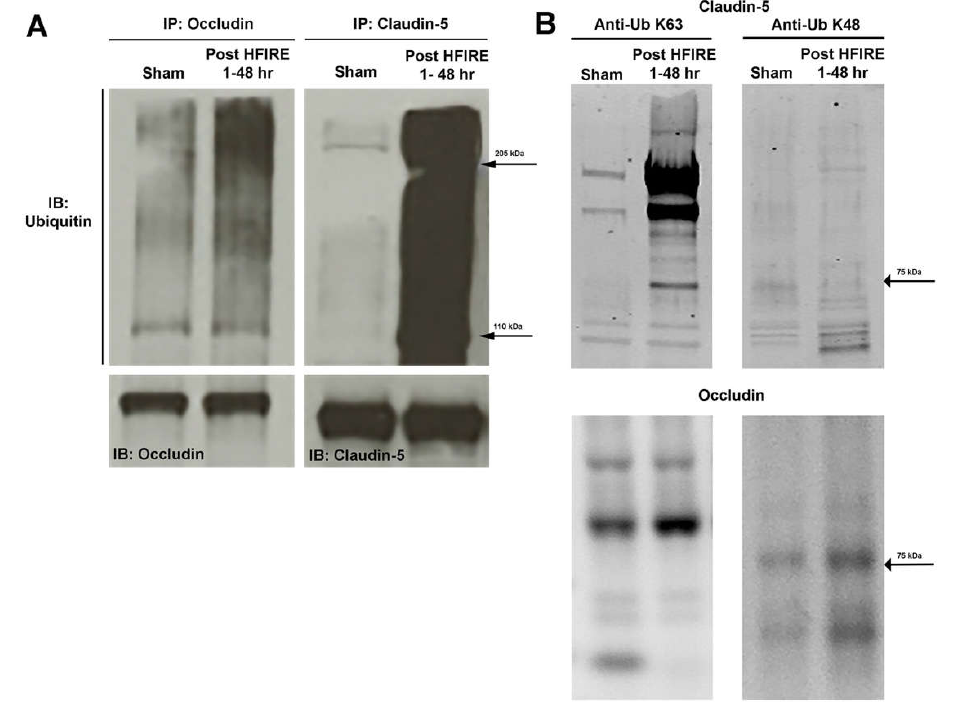
Figure 7. Intracranial H-FIRE resulted in increased occludin and claudin-5 ubiquitination for up to 48 h post-treatment ( A ), indicating post-translational modifications contribute to the inverse correlation observed between levels of mRNA transcripts and protein. Both K63 and K48 linkage specific ubiquitination of claudin-5 and occludin increased after H-FIRE treatment ( B ).